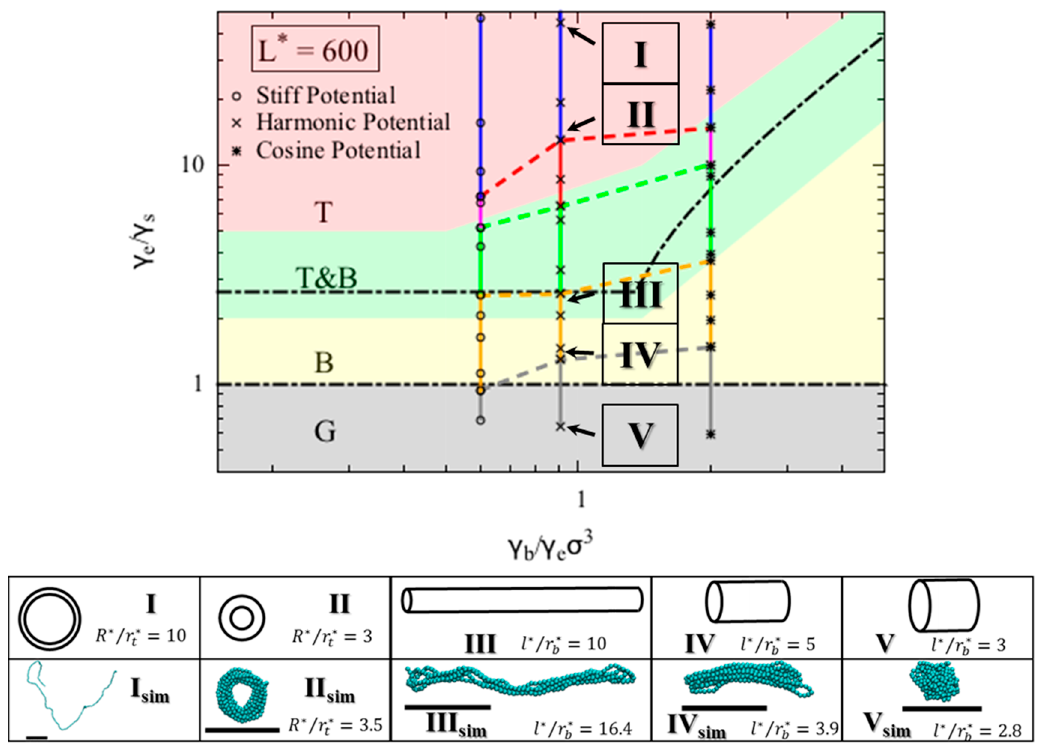
Figure 3. Phase diagrams for polymer chain with dimensionless chain length L * = L / σ = 600. Each symbol on the phase diagram marks the parameter values at which a simulation was conducted. Specifically, open circles, crosses, and asterisk symbols are the simulation runs using stiff, harmonic, and cosine bending potentials respectively. A vertical bar connects simulations data producing the same type of structure. The color of the vertical bars, of the dashed lines, and of the regions of the diagram producing this structure coded as follows: blue—random coil (RC), pink—fluctuating between random coil and torus (RC&T), red—torus (T), green—fluctuating between torus and bundle (T&B), yellow—bundle (B), and black- globule (G). Note the pink and blue regions only occur in simulations because we do not model random coil phase. We regard the simulated T&RC phase simply as a torus phase (T) because we do not model the random coil (RC) phase analytically. The dashed lines connecting the vertical bars mark the upper boundaries of the phases obtained from the simulations (e.g., simulation results between yellow and grey dashed lines resulted in a bundle as the final collapsed structure). Exact solutions for the boundaries between the three collapsed phases are shown on the phase diagram (black dash-dotted lines). We have selected representative conformations in each phase, pointed by the arrows. We have calculated the theoretical aspect ratios for these conformations, depicted in the insets I–V. We have also conducted simulations using harmonic bending potential under the same conditions, and the final snapshots from the simulations are supplied in additional insets I–V with subscript “sim”.